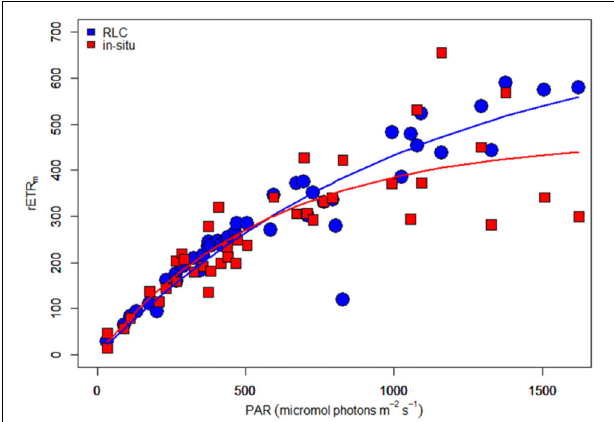
FIGURE 11 | “Composite” rapid light curves (electron transport rate versus irradiance) based on data obtained with sequential steps of increasing artificial light (blue dots) or naturally varying ambient solar irradiance data (red squares). The lines give the predicted rETR rates obtained from a fit of the data to the equation of Webb et al. (1974).